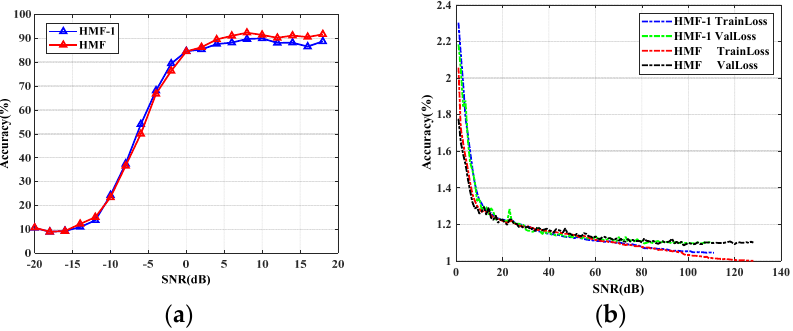
Figure 7. Comparison of the proposed HMF-I and HMF in ( a ) classification accuracy and ( b ) training curves.